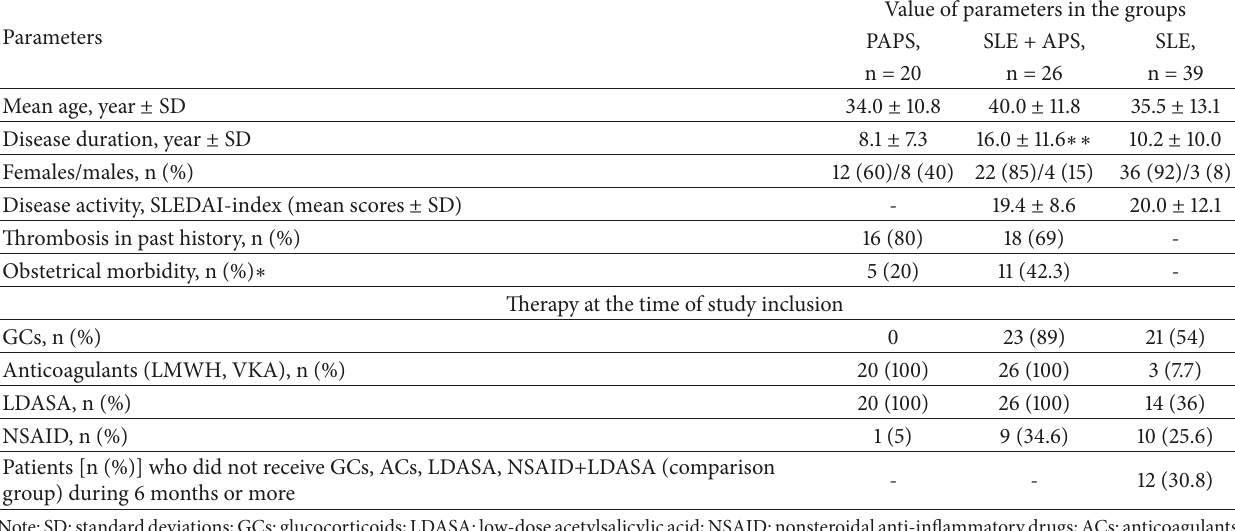
Table 1: Characteristics of patients included in the